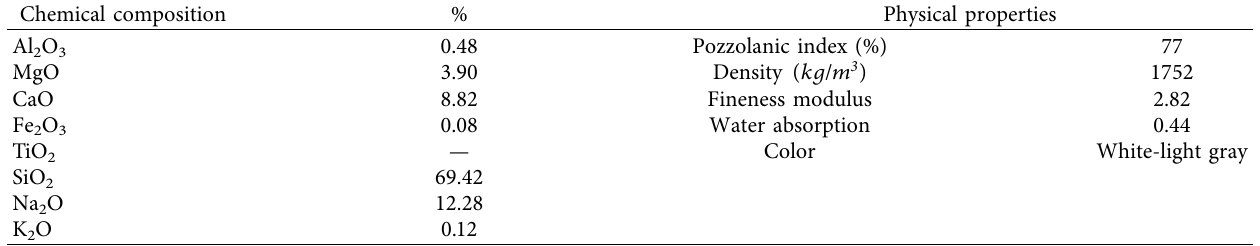
Table 4: Chemical composition and physical properties of waste glass powder [51].